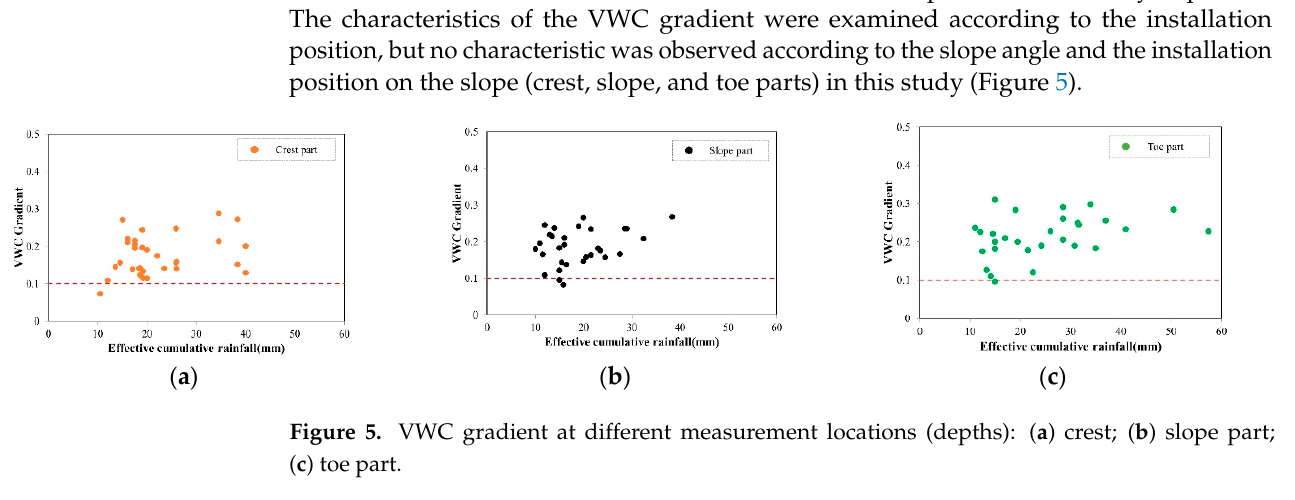
Figure 5. VWC gradient at different measurement locations (depths): ( a ) crest; ( b ) slope part; ( c ) toe part.